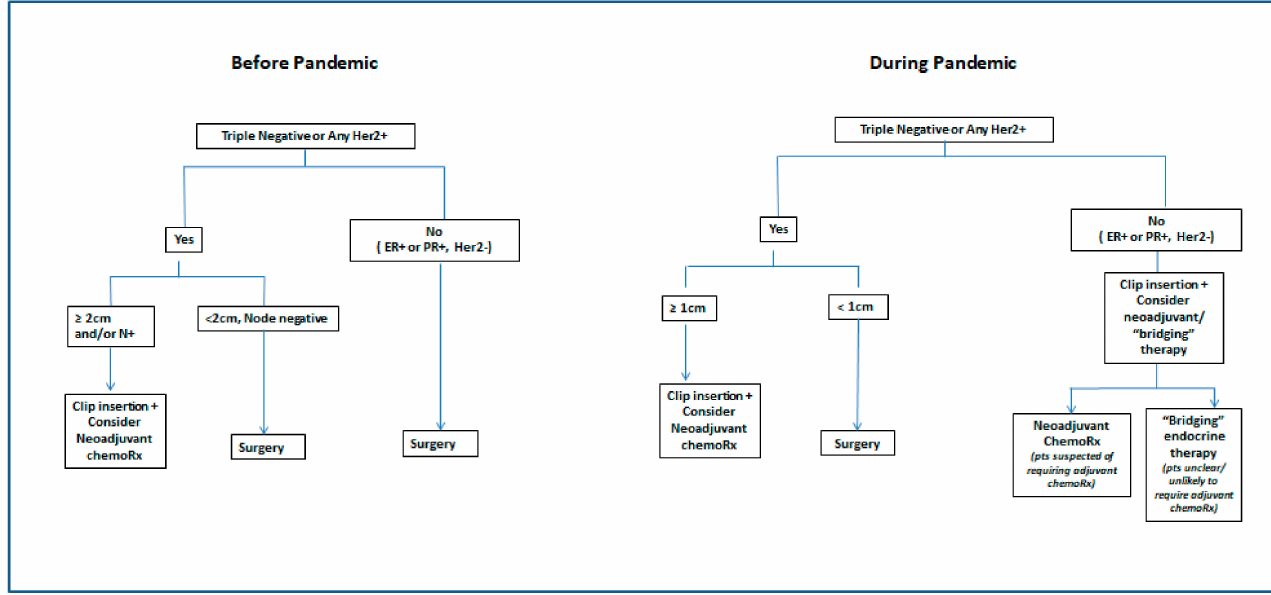
Figure 2. Criteria for neoadjuvant chemotherapy before and during the pandemic at the Ottawa Hospital Cancer Cen- ter. “Bridging therapy” refers to endocrine therapy given to temporize surgical treatment. ChemoRX: Chemotherapy; Pts: